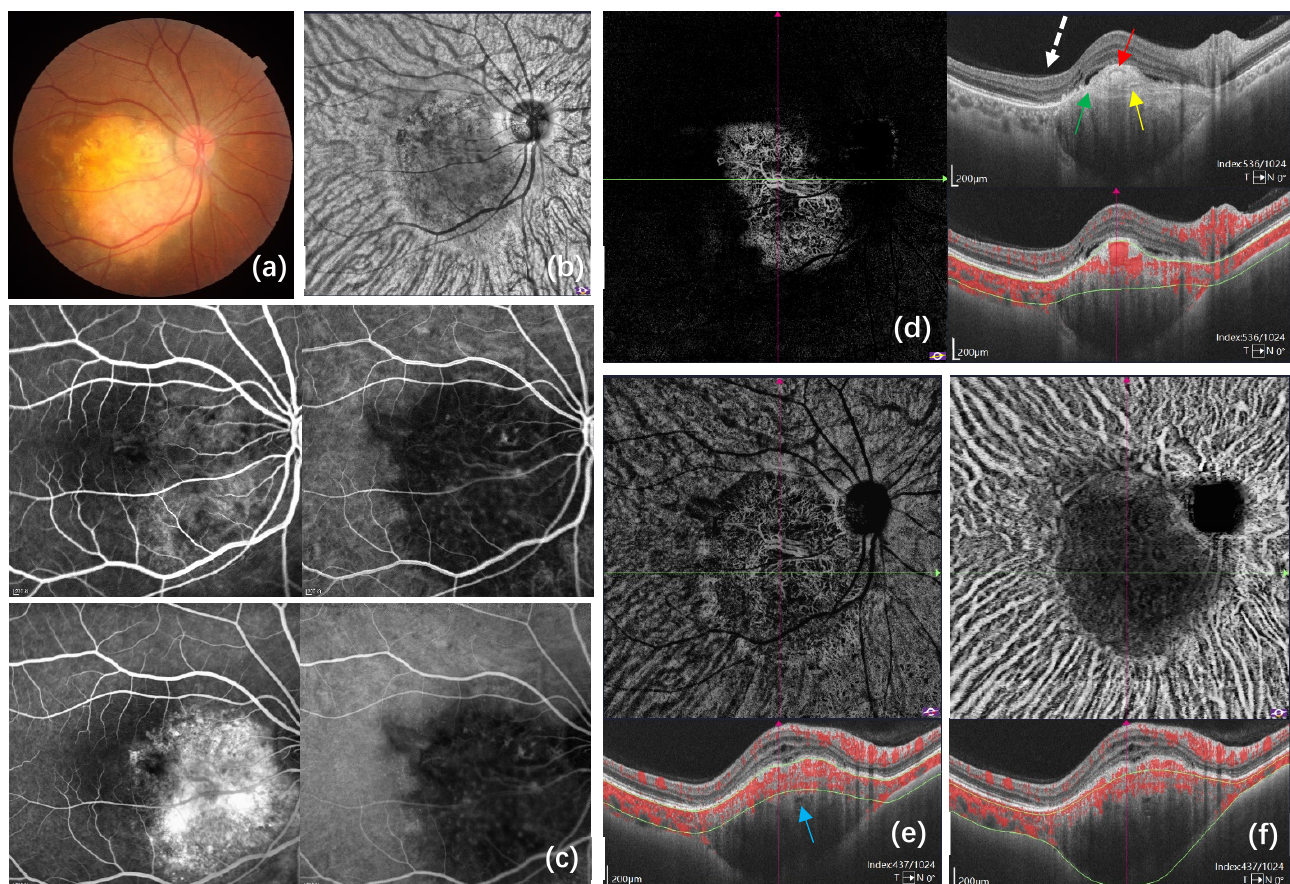
Figure 4. Multimodal imaging of patient 1 (see Table 1): ( a ) fundus photography shows an orange- yellow CO at the macula with subretinal hemorrhage; ( b ) an en face image corresponding to ( f ); ( c ) FA and ICGA show an early hyperfluorescent network with dye leakage; ( d ) the avascular layer of SS-OCTA and corresponding B-scan show a hyperreflective area (the neovascular network interlacing with feeder vessels of the tumor) growing above the disrupted Bruch’s member (green arrow) on the slope of the focal choroidal excavation (dashed white arrow). This area contains hyporeflective tubular lamella (red arrow, presumed to be feeder vessels of the tumor) that could show blood flow signals and hyperreflective horizontal lamellar lines (yellow arrow, presumed to be bone lamella or cement lines); ( e ) SS-OCTA of the choriocapillaris layer shows the blood flow signal of the osteoma is located mainly within the choriocapillaris and partly the Sattler’s layer on the composite B-scan. The hyporeflective tubular areas (blue arrow), which were interpreted as intratumoral vessels, did not detect a flow signal; ( f ) SS-OCTA segmentation covering the entire border of the osteoma on the aligned B-scan images shows the boundary of the tumor clearly demarcated from the adjacent vessels of the choroidal Sattler’s layer and Haller’s